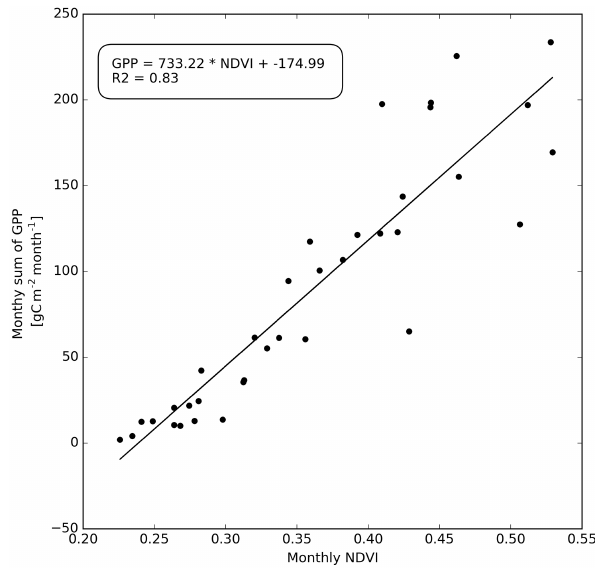
Figure 9. Linear regression between the monthly NDVI and the monthly sum of